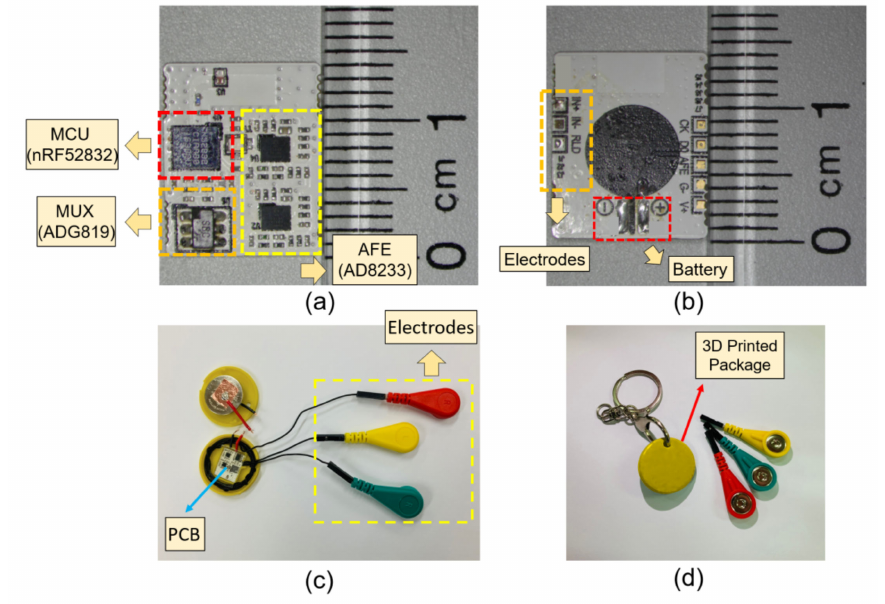
Figure 4. Images of the fabricated device. ( a ) Top view of the populated PCB; ( b ) bottom view of the PCB; ( c ) image of the device encapsulated in a button shaped container with the cap open; ( d ) the cap of the container is closed, ready for